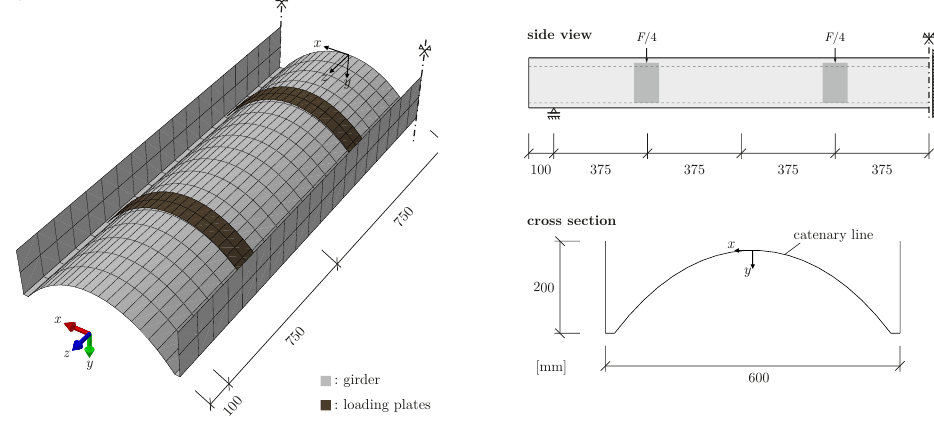
Figure 17. Finite element model of the lightweight girder: ( a ) finite element mesh and ( b ) dimensions of the girder cross section.